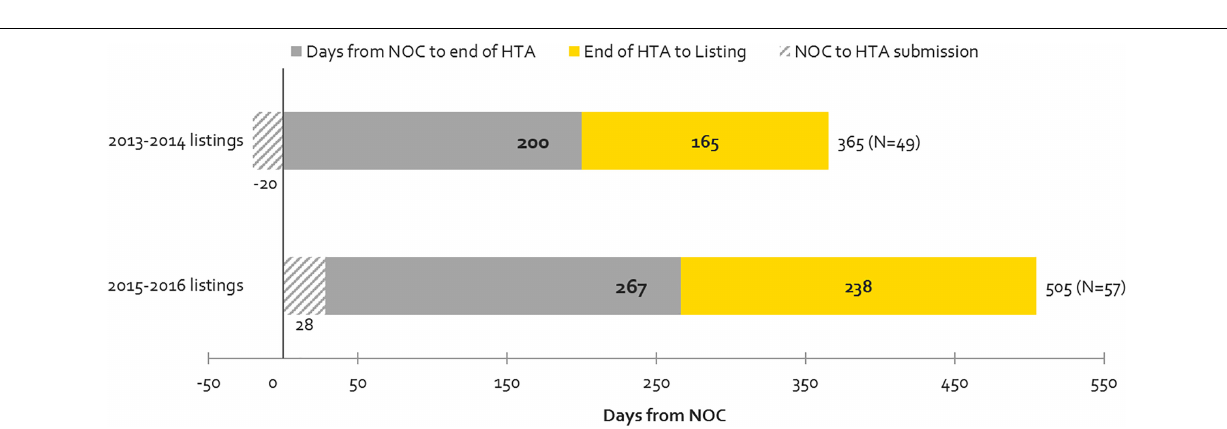
FIGURE 5 | Time to First Provincial Listing, in number of days, (all provinces, excluding Quebec), as segmented based on the following timelines: from NOC to HTA submission; from NOC to HTA recommendation; and from HTA recommendation to listing (source: CADTH reviews, excluding